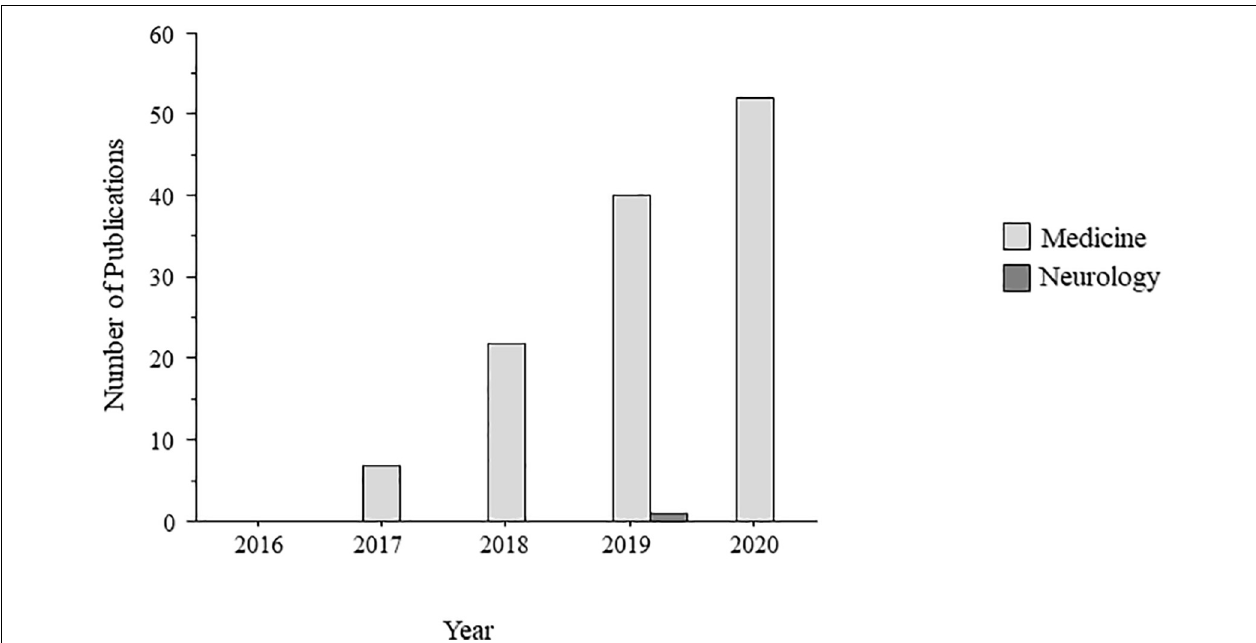
FIGURE 1 | Number of publications divided per year in Medline database with the terms “Blockchain” and “Medicine” or “Neurology.” The searches with the terms “brain,” “neuron,” “cortex,” “cell,” “stem cells,” “mind,” or “Neurological diseases” retrieved no results. Note the exponential increase in publications with the term